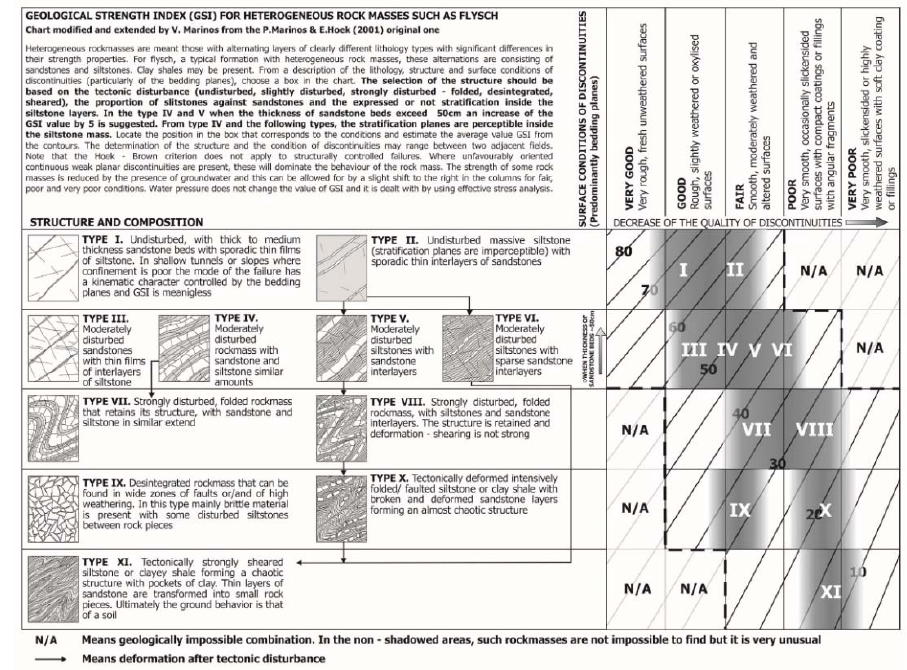
Figure 8. Geological strength index (GSI) chart for heterogeneous and structurally complex rock masses, such as flysch used for rock mass quality classification. N/A: Not applicable cases in nature.